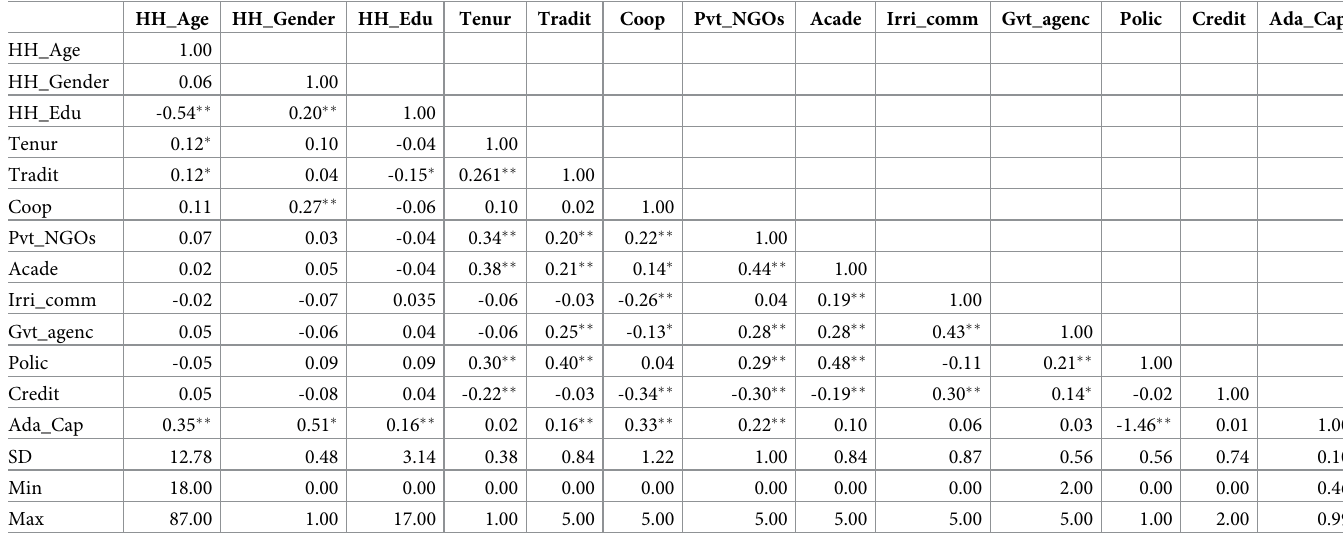
Table 6. Descriptive statistics and correlation among